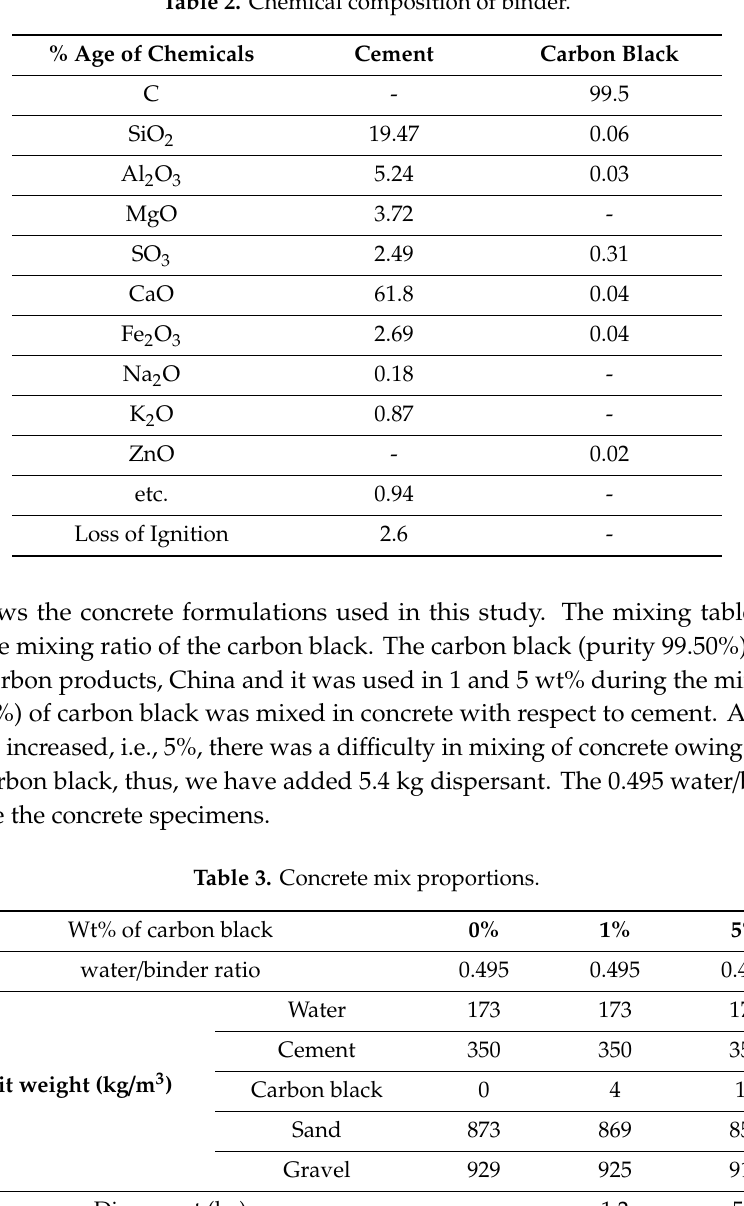
Table 2. Chemical composition of binder.